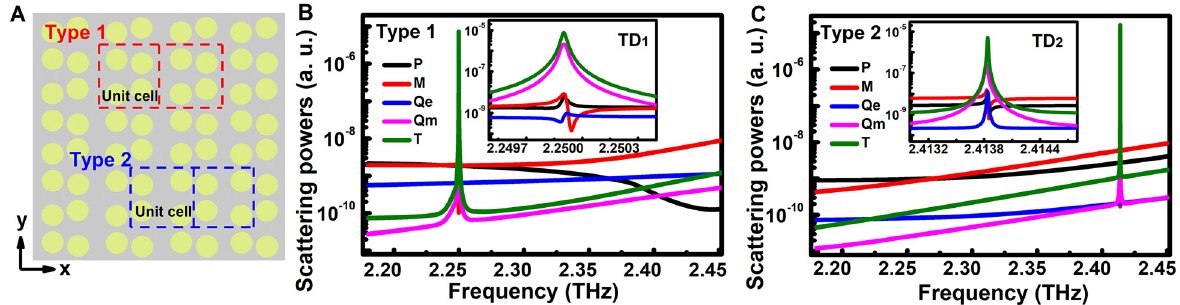
Figure 3: (A) Top view ( x – y plane) of the asymmetric metasurface structure, the red dashed boxes indicate the unit cell of Type 1, and the blue dashed boxes indicate the unit cell of Type 2. The scattering powers of multipole decomposition for (B) the unit cell of Type 1 and (C) the unit cell of Type 2, where P , M , Qe, Qm, and T are the ED, MD, electric quadrupole, magnetic quadrupole, and electric toroidal dipole, respectively. The insets are larger versions of the scattering powers for TD 1 and TD 2